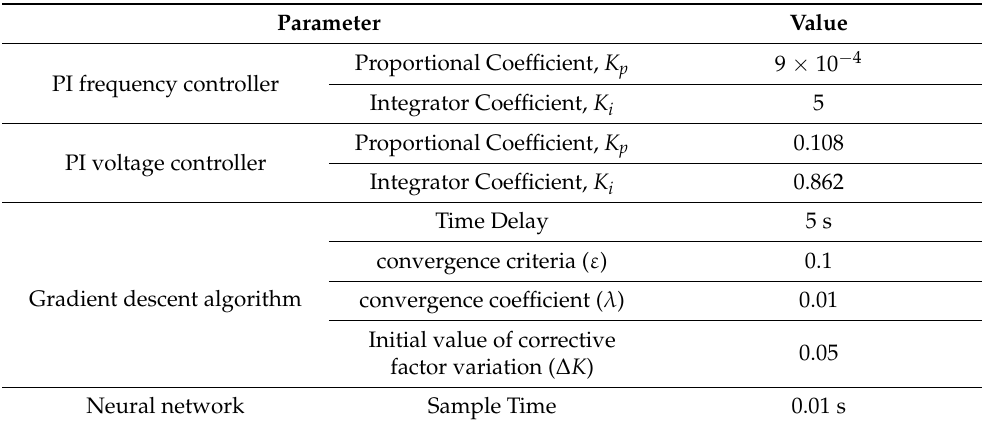
Table 2. Controller parameters.